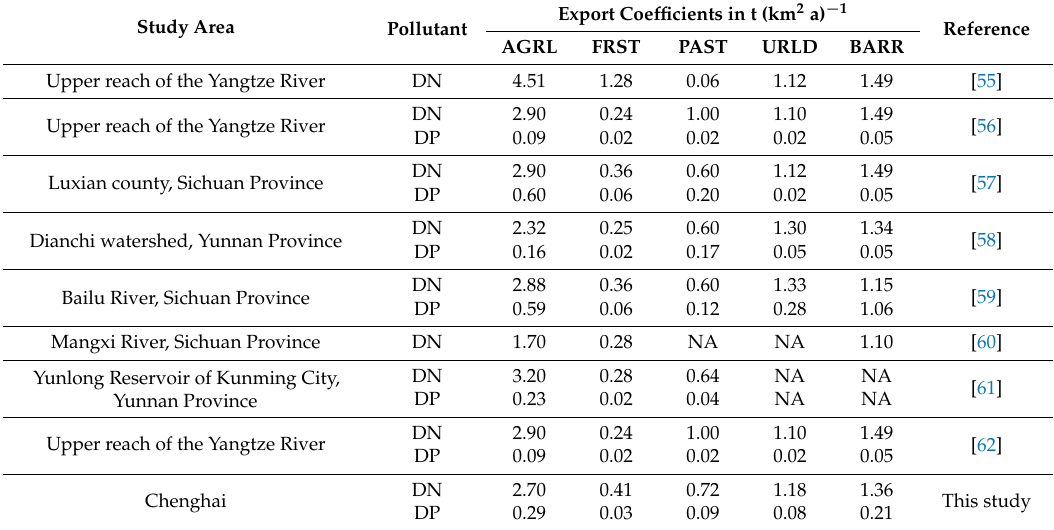
Table 1. Yearly export coefficients for the different land-use types reported by various studies. Study